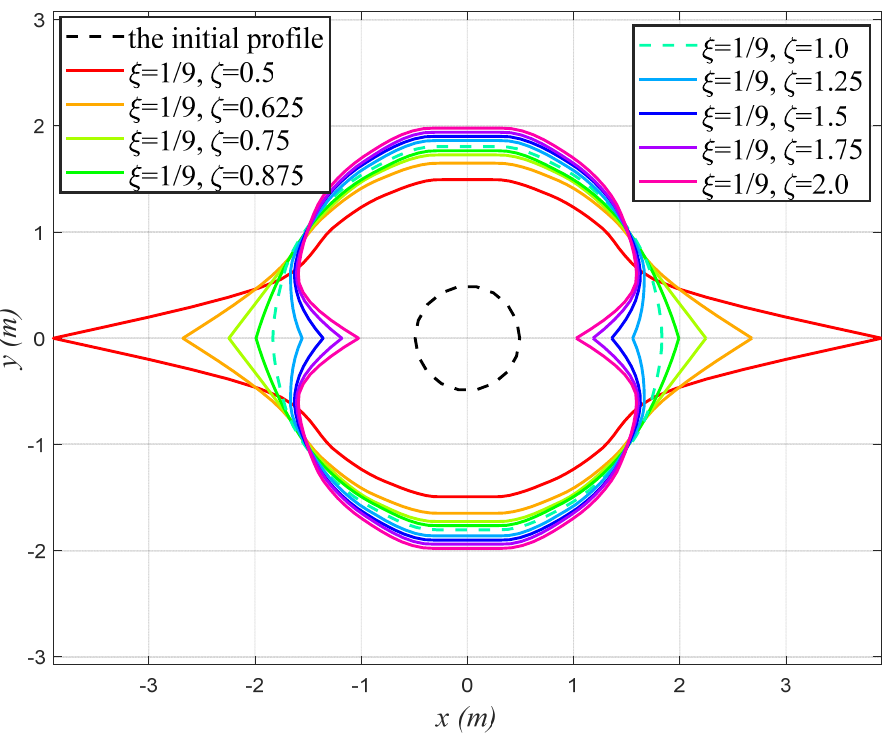
Figure 15. Fracture profiles on the plane xoy of Group 1 experiments under ξ = 1/9 at the moment = 20s.